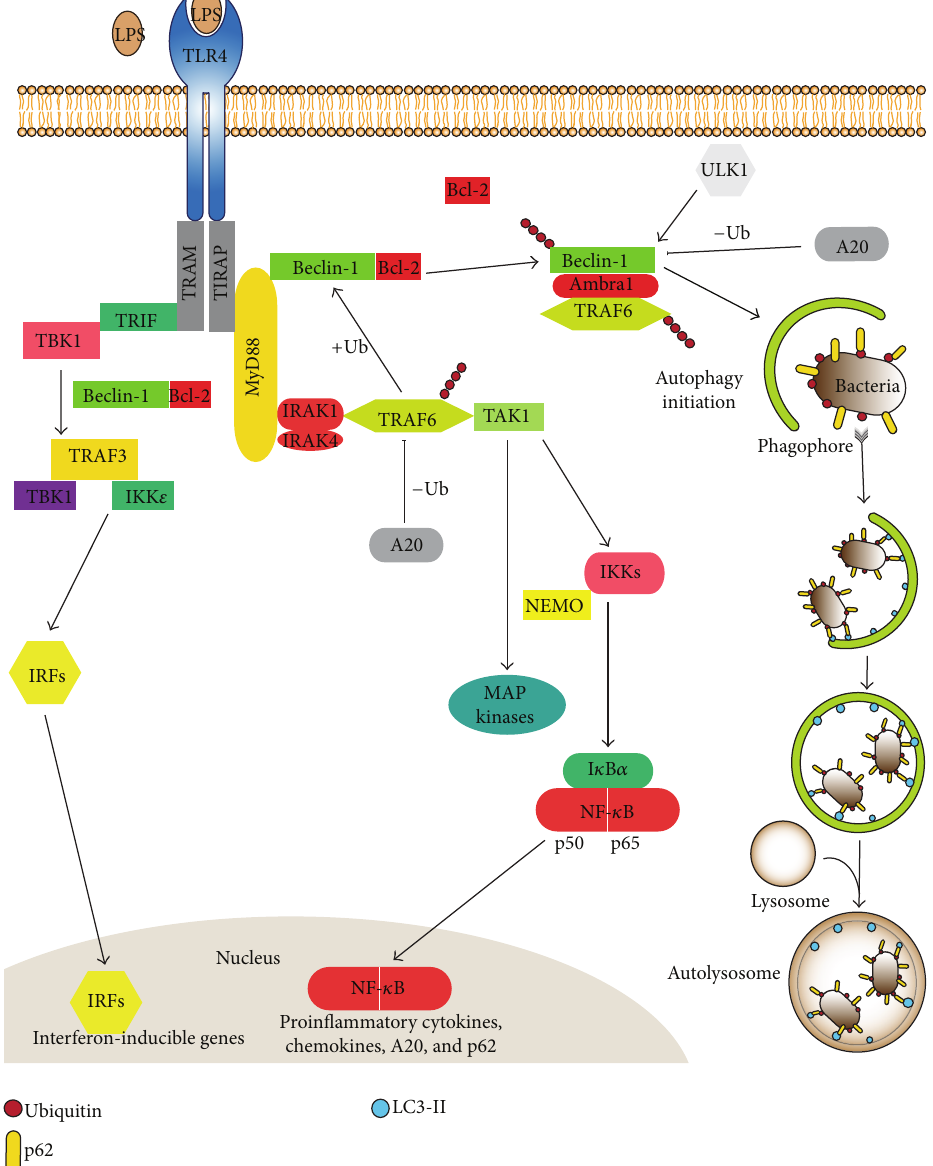
Figure 2: The downstream molecular pathways following the activation of TLR4 receptor by lipopolysaccharide (LPS) are shown. The adapter protein MyD88 is recruited by TLR4 and activates the transcription factor nuclear factor- 𝜅 B (NF- 𝜅 B) and mitogen-activated protein kinases (MAPKs), whose major functions include the induction of proinflammatory cytokines, chemokines, A20, and p62. TRIF is another adapter protein recruited by TLR4. It causes the activation of interferon regulatory factor-3 (IRF3) and NF- 𝜅 B leading to induction of type I interferon and inflammatory cytokines. In addition, LPS-induced TLR4 activation recruits Beclin-1 through adapter proteins MyD88 and TRIF leading to formation of autophagosomes. The ubiquitination status of Beclin-1 is regulated by the TRAF6/A20 axis, which has a regulatory role in the induction of autophagosomes in response to pathogens. Pathogens can be ubiquitinated and thereby recruit autophagic adaptors like